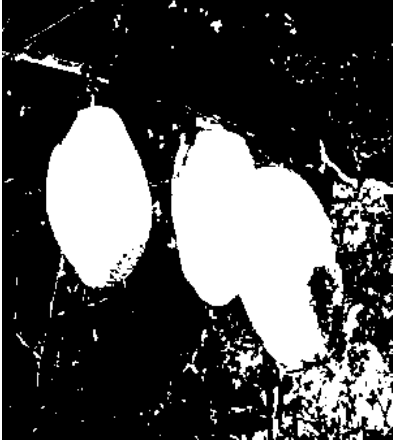
Figure 7. Segmented result rotated by a certain